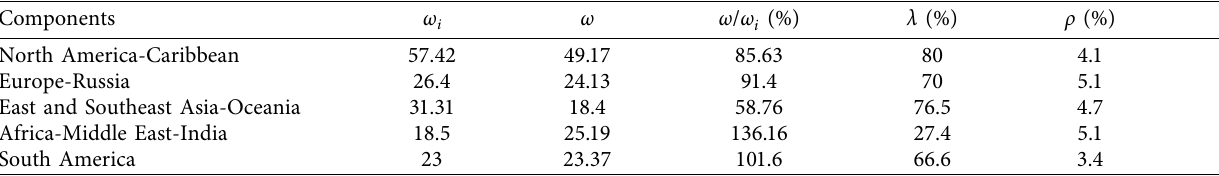
Table 5: Evolution of the weighted efciency and the LCC of the large local components after their isolation due to attacks based on weighted betweenness. We also report the order of isolation of the components. ω i is the weighted efciency before the attack based on weighted betweenness. ω is the weighted efciency after the separation. λ is the largest connected component size after the split. ρ is the fraction of top weighted betweenness nodes removed from the world air transportation network to isolate the component. c is the order in which the components are isolated. Globally, after their isolation, the efciency of the LCC does not change much. Some LCCs are even more